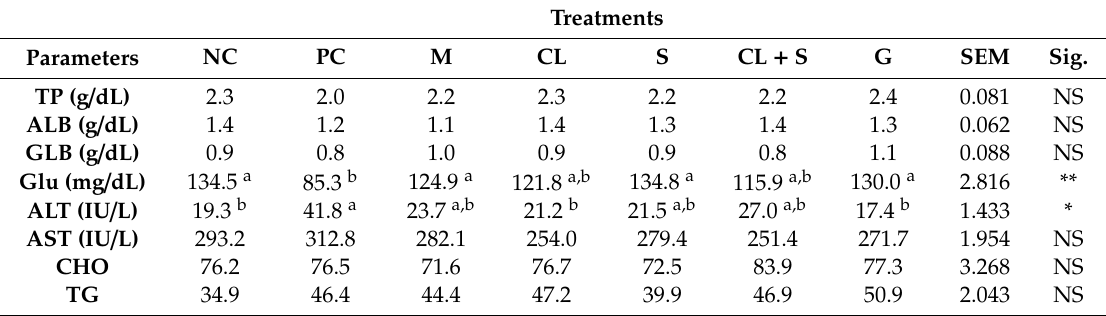
Table 5. E ff ect of probiotic diets supplementation on blood profile of broiler chicks challenged with C. perfringens